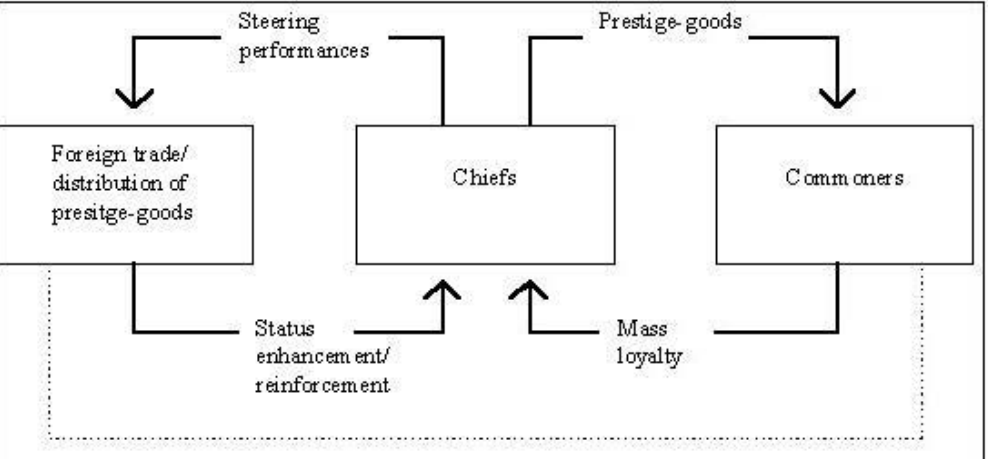
figure 4. Revised conception of socio-political organization applied to Moumt .... 'illc. Collapse of the M.oundvillc